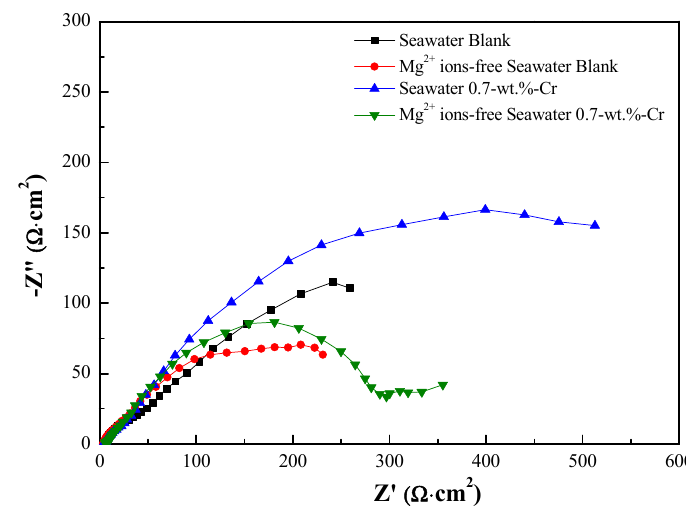
Figure 4. Nyquist plots for specimens immersed in 60 °C seawater for 30 days.